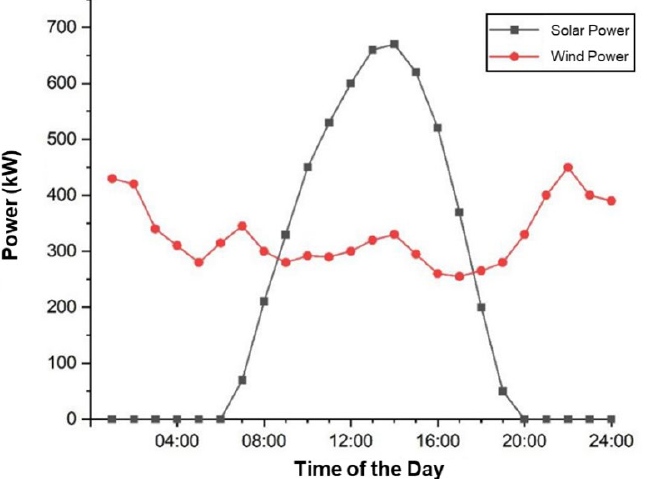
Figure 2. Curves of predicted power generation by wind and solar energies. Table 2 lists the operation parameters of each energy storage device in the system. Table 2. Operation parameters of energy storage devices.